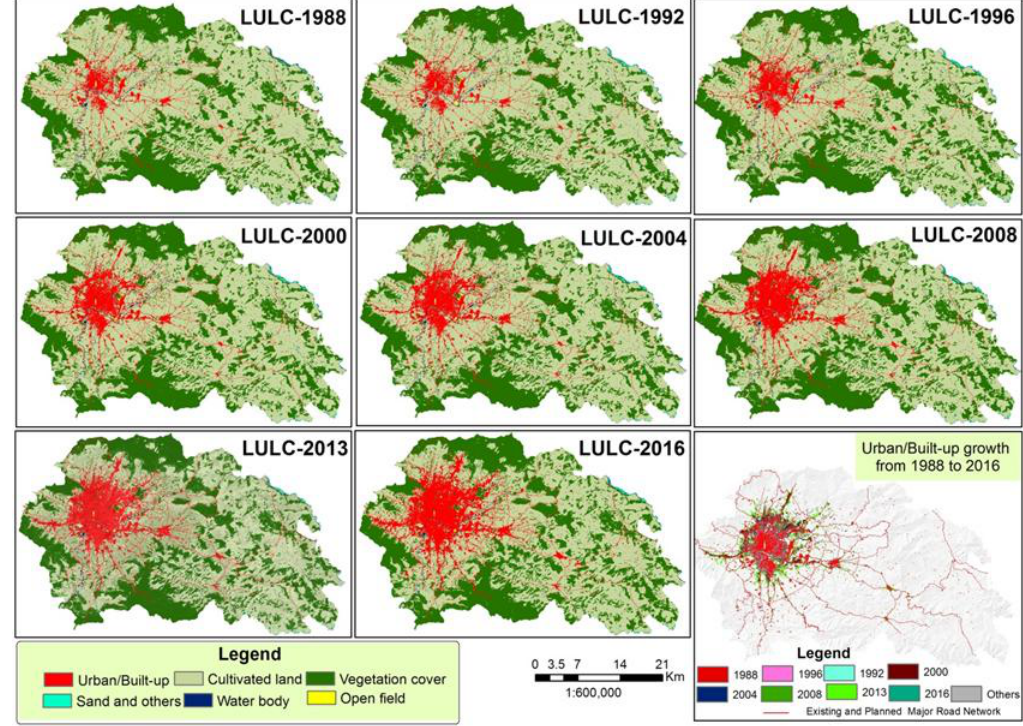
Figure 4. Land-use/land-cover (LULC) Map from 1988 to 2016.